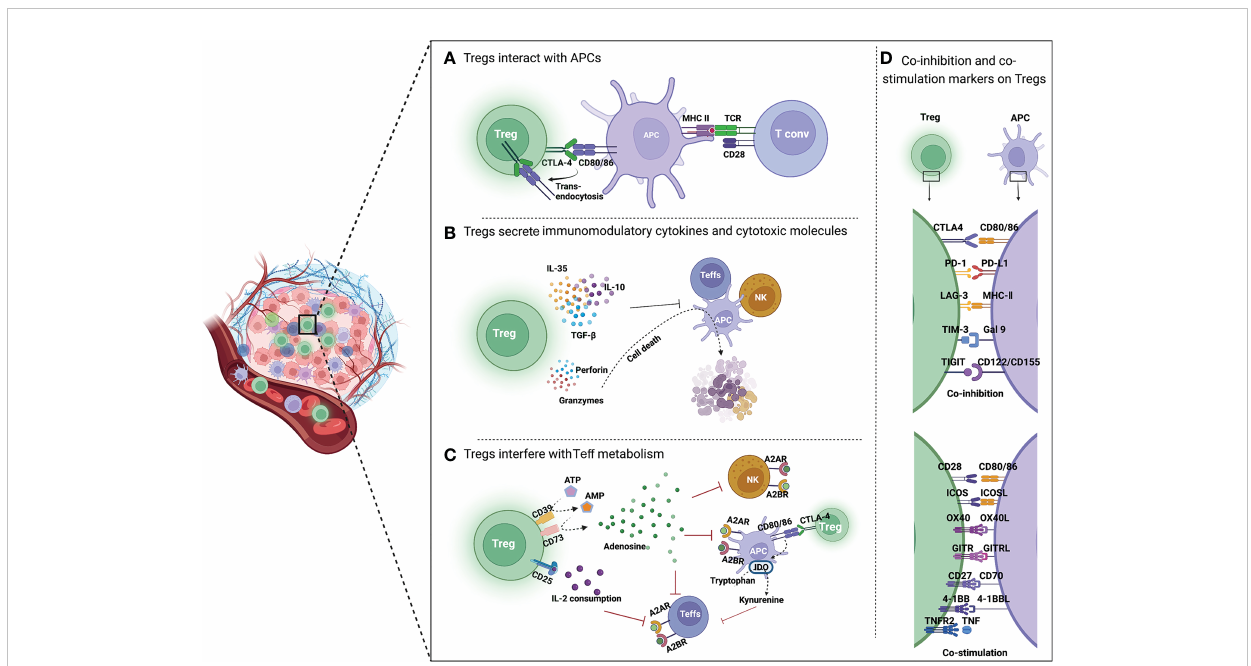
FIGURE 2 Mechanisms of Treg-mediated immunosuppression in TME. (A) Tregs inhibit the function of APCs and Teffs through immune checkpoints. CTLA4 is highly expressed on Tregs, which binds to CD80/86 on APCs, reduces CD80/86 expressed by APCs through trans-endocytosis, and inhibits the activation of T cells by APCs. (B) Tregs secrete immunomodulatory cytokines and cytotoxic molecules. Tregs directly inhibit the activation of Teffs, NK cells and APCs by secreting immunosuppressive cytokines such as IL-35, IL-10 and TGF- b . Moreover, Tregs can kill immune cells by directly secreting perforin and granzyme, leading to cell apoptosis. (C) Tregs interfere with Teff metabolism. CD39 converts extracellular ATP to generate AMP, which is then cleaved by CD73 to produce immunosuppressive molecular adenosine. Adenosine binds to receptors (A2A or A2B) on the surface of Teffs, APCs and NK cells, resulting in their immunosuppression. CTLA4 induces IDO production by APCs, which can oxidize tryptophan to kynurenine. Tryptophan is an essential amino acid for maintaining T cell activation. (D) Co-inhibition and co-stimulation molecules expressed by Tregs and their ligands. Tregs express a range of co-inhibition molecules of immune checkpoints (CTLA4, PD-1, LAG3, TIM3, and TIGIT) and co- stimulation molecules of Ig superfamily (CD28 and ICOS) as well as TNFR superfamily (OX40, GITR, CD27, 4-1BB, and TNFR2) on the